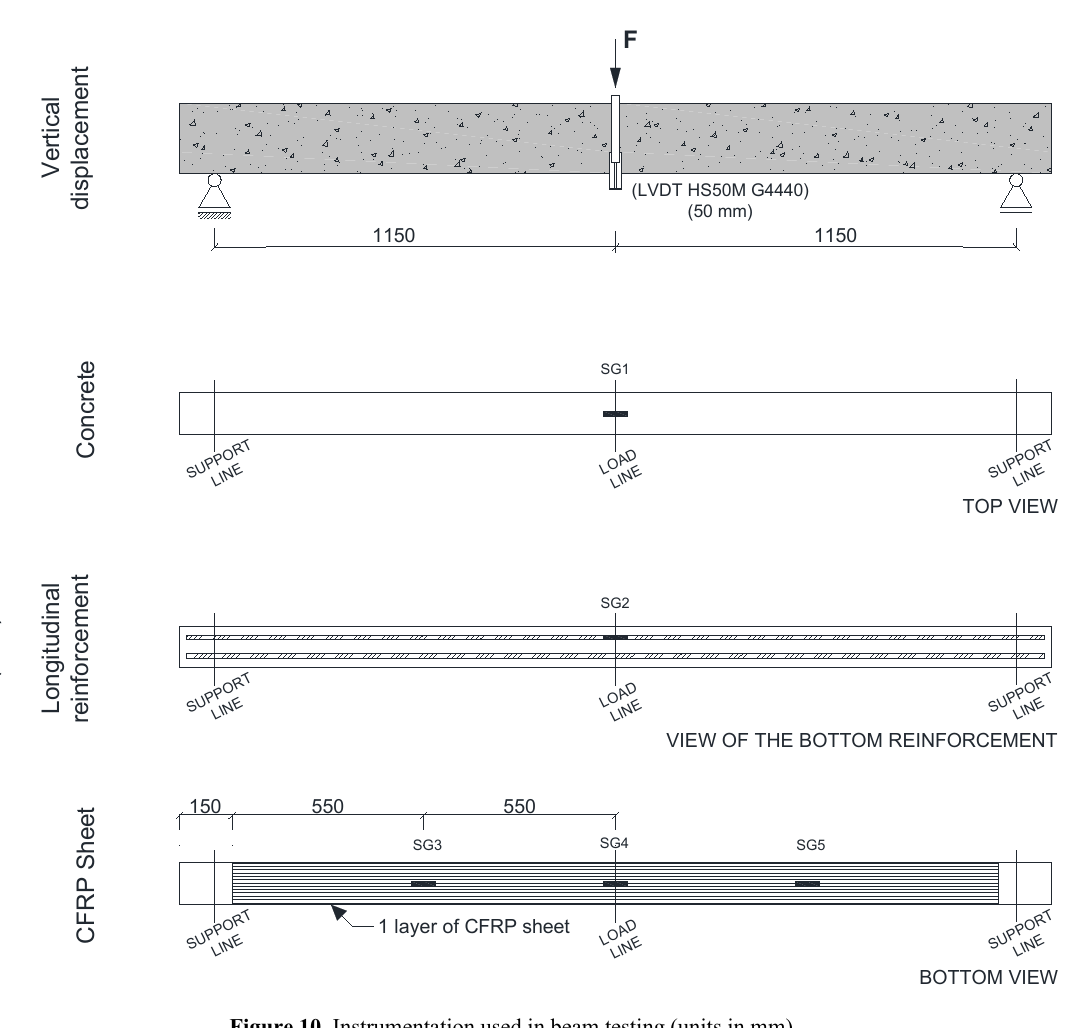
Figure 10. Instrumentation used in beam testing (units in